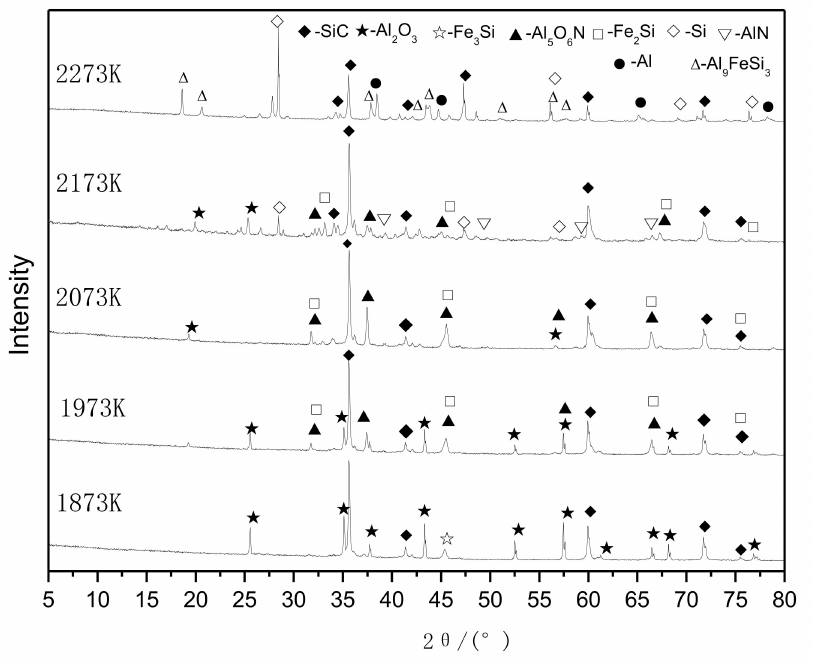
Figure 6. XRD patterns of the residues at 1873 K~2273